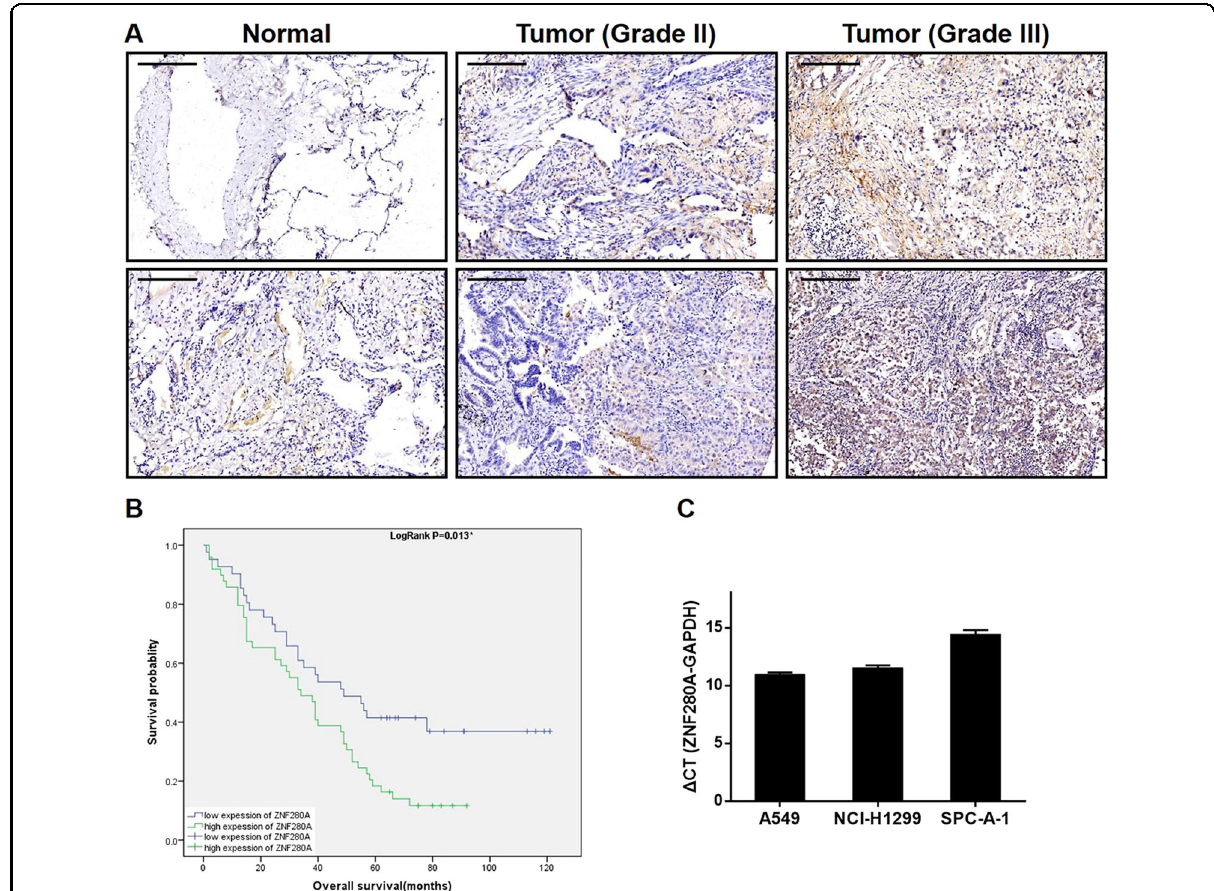
Fig. 1 ZNF280A was upregulated in LUAD tissues and expressed in LUAD cells. A The expression level of ZNF280A was detected by IHC analysis in LUAD tissues and normal tissues (Scale bar = 50 μ m). B The Kaplan – Meier survival analysis showed a signi fi cant association between ZNF280A high expression and shorter survival period of LUAD patients. C The mRNA expression of ZNF280A in A549, NCI-H1299, and SPC-A-1 cell lines was detected by qPCR. Data were shown as mean ± SD. * P < 0.05, ** P < 0.01, *** P < 0.001.